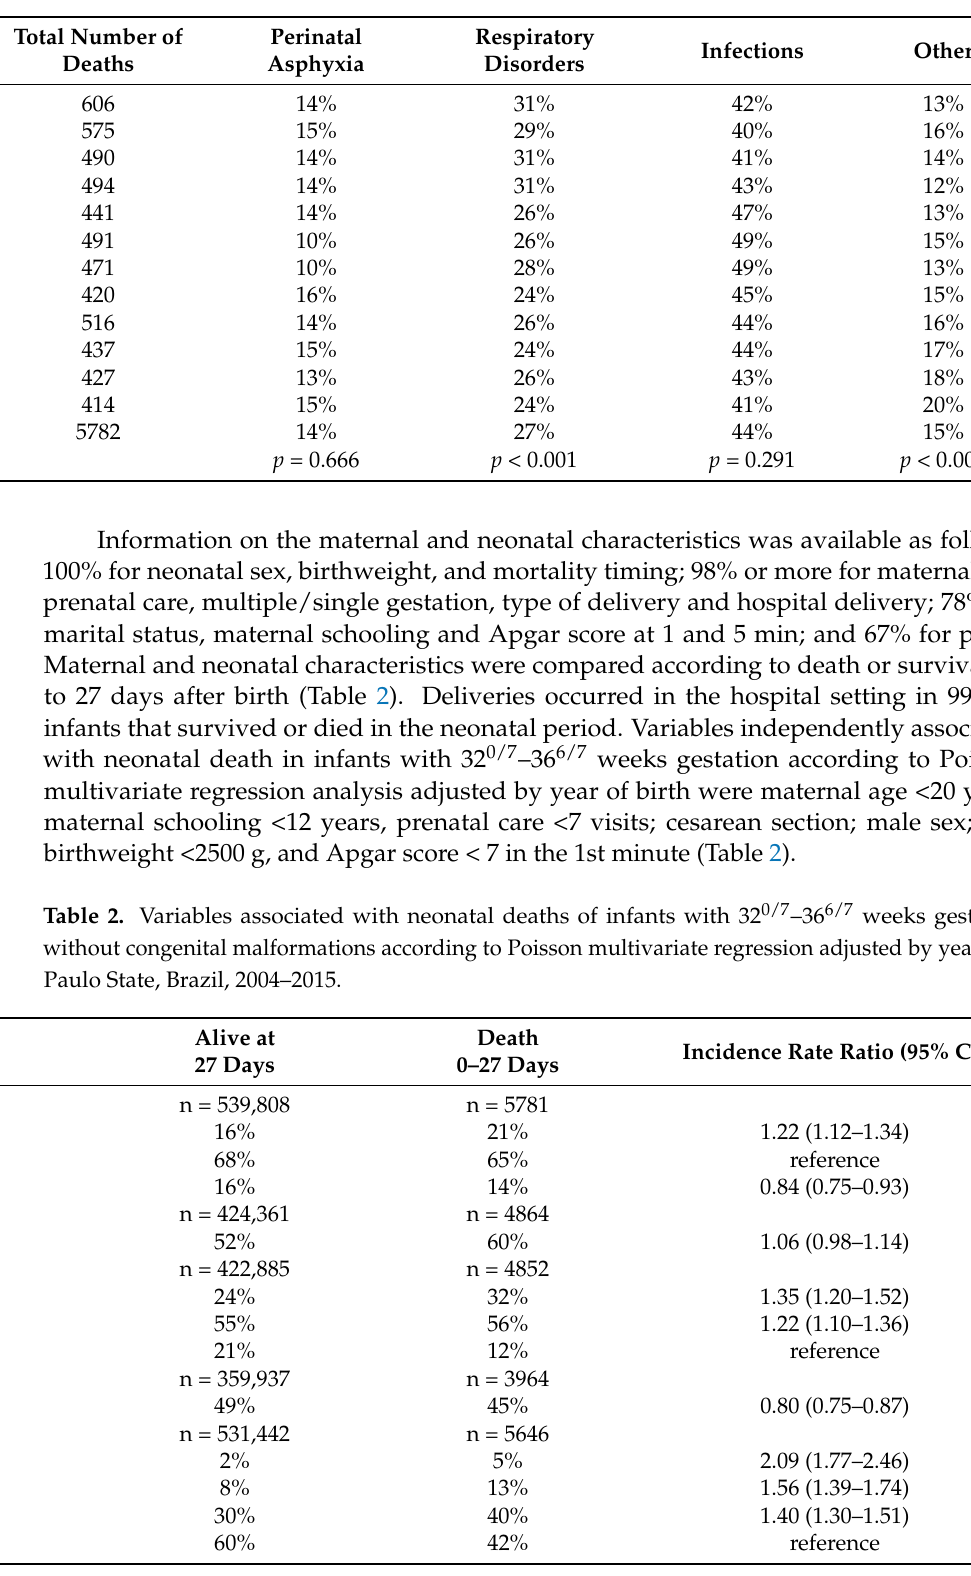
Table 1. Causes of neonatal death of preterm infants with 32 0/7 –36 6/7 weeks gestation without congenital malformations. S ã o Paulo State, Brazil, 2004–2015.